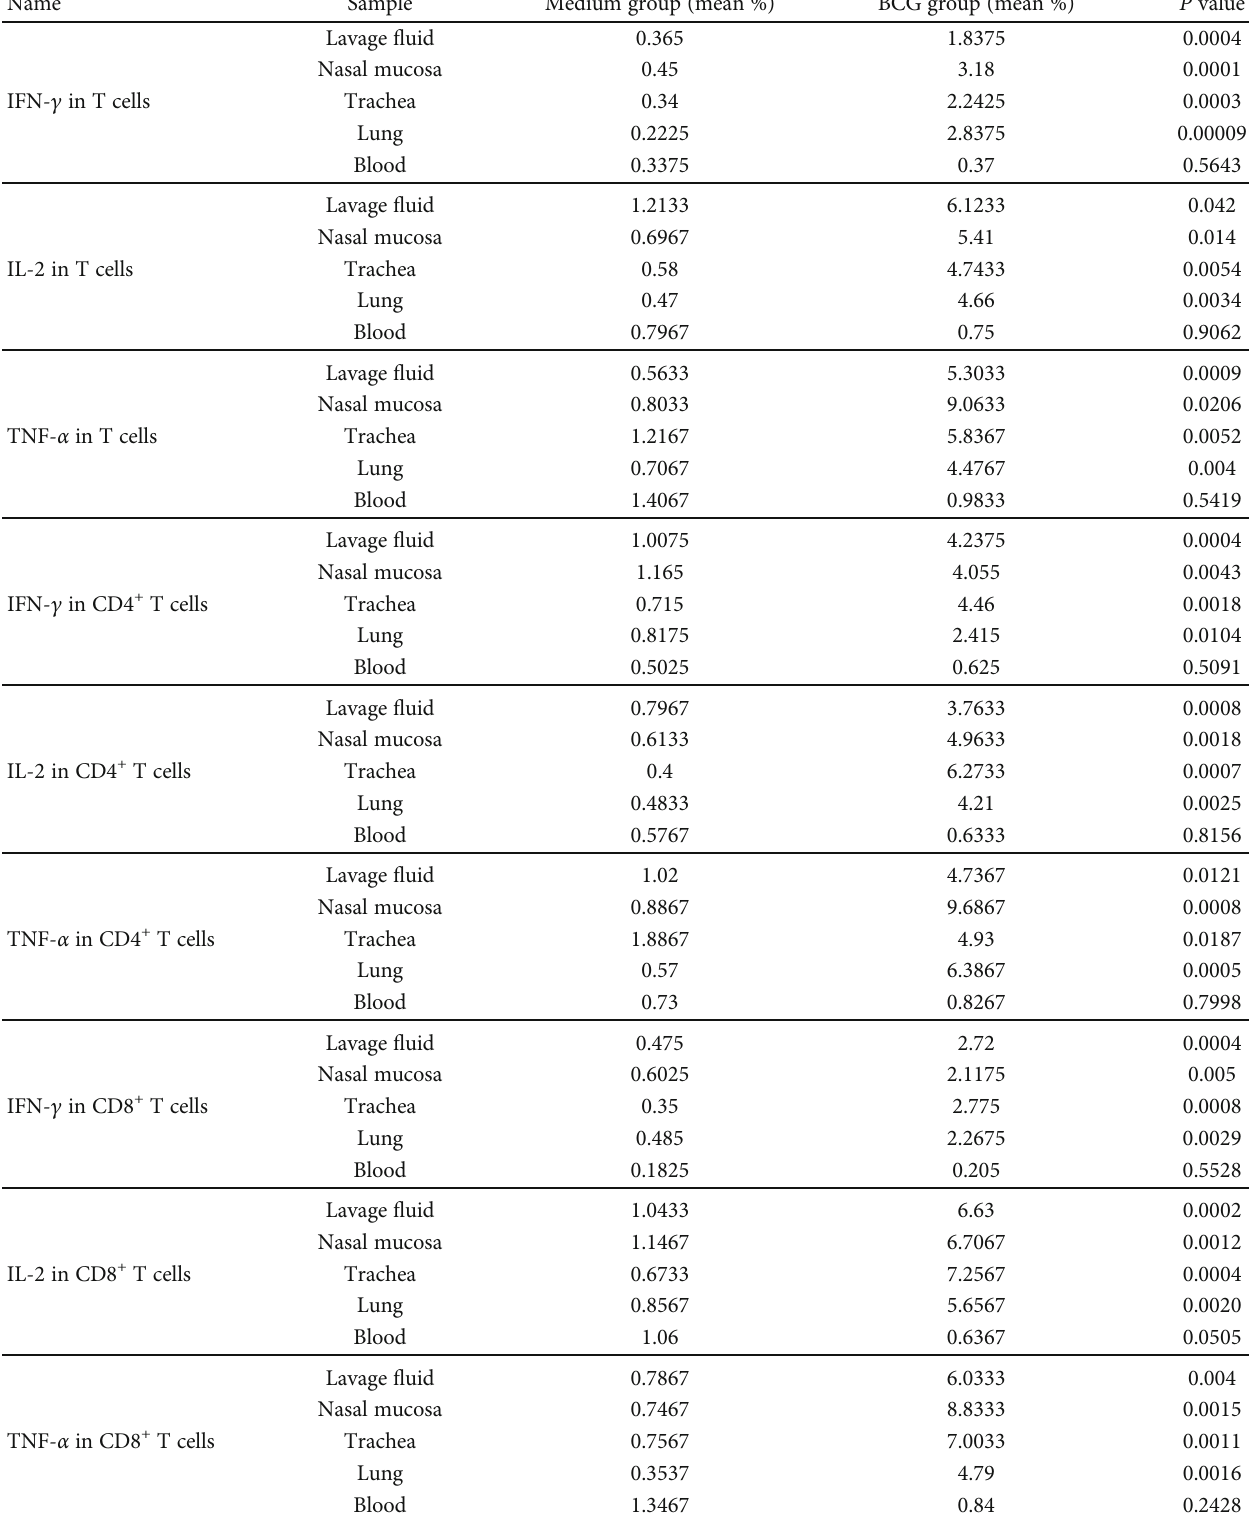
Table 3: The expression of cytokines in T cells of the respiratory system and in blood before and after